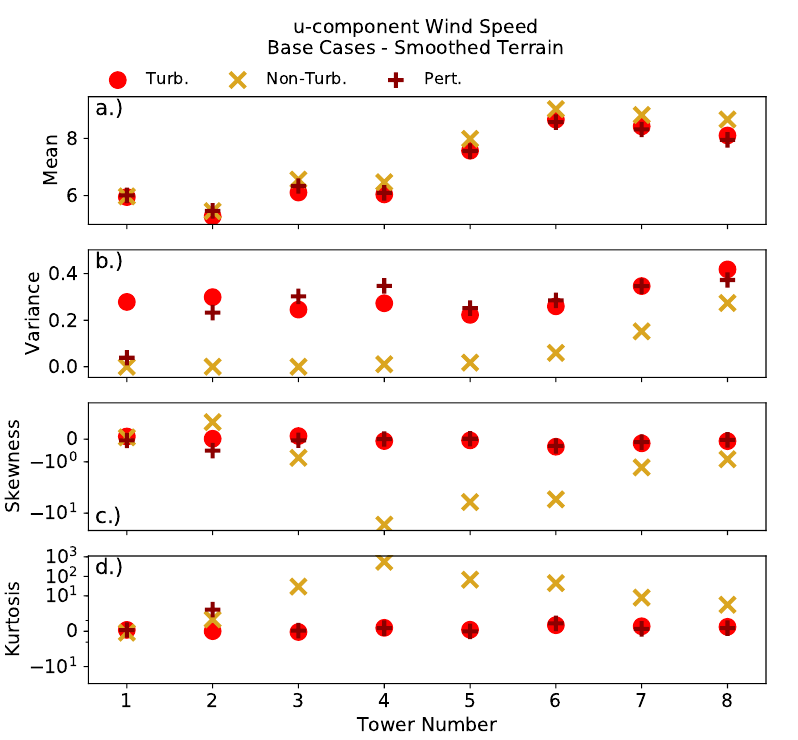
Figure 11. The tower line average mean ( a ), variance ( b ), skewness ( c ), and kurtosis ( d ) for each of the eight tower lines calculated from the time series of the u -component winds at 110 m in the smoothed terrain Base cases. Note that the y-axis in panels ( c , d ) is symmetrical logarithmic.